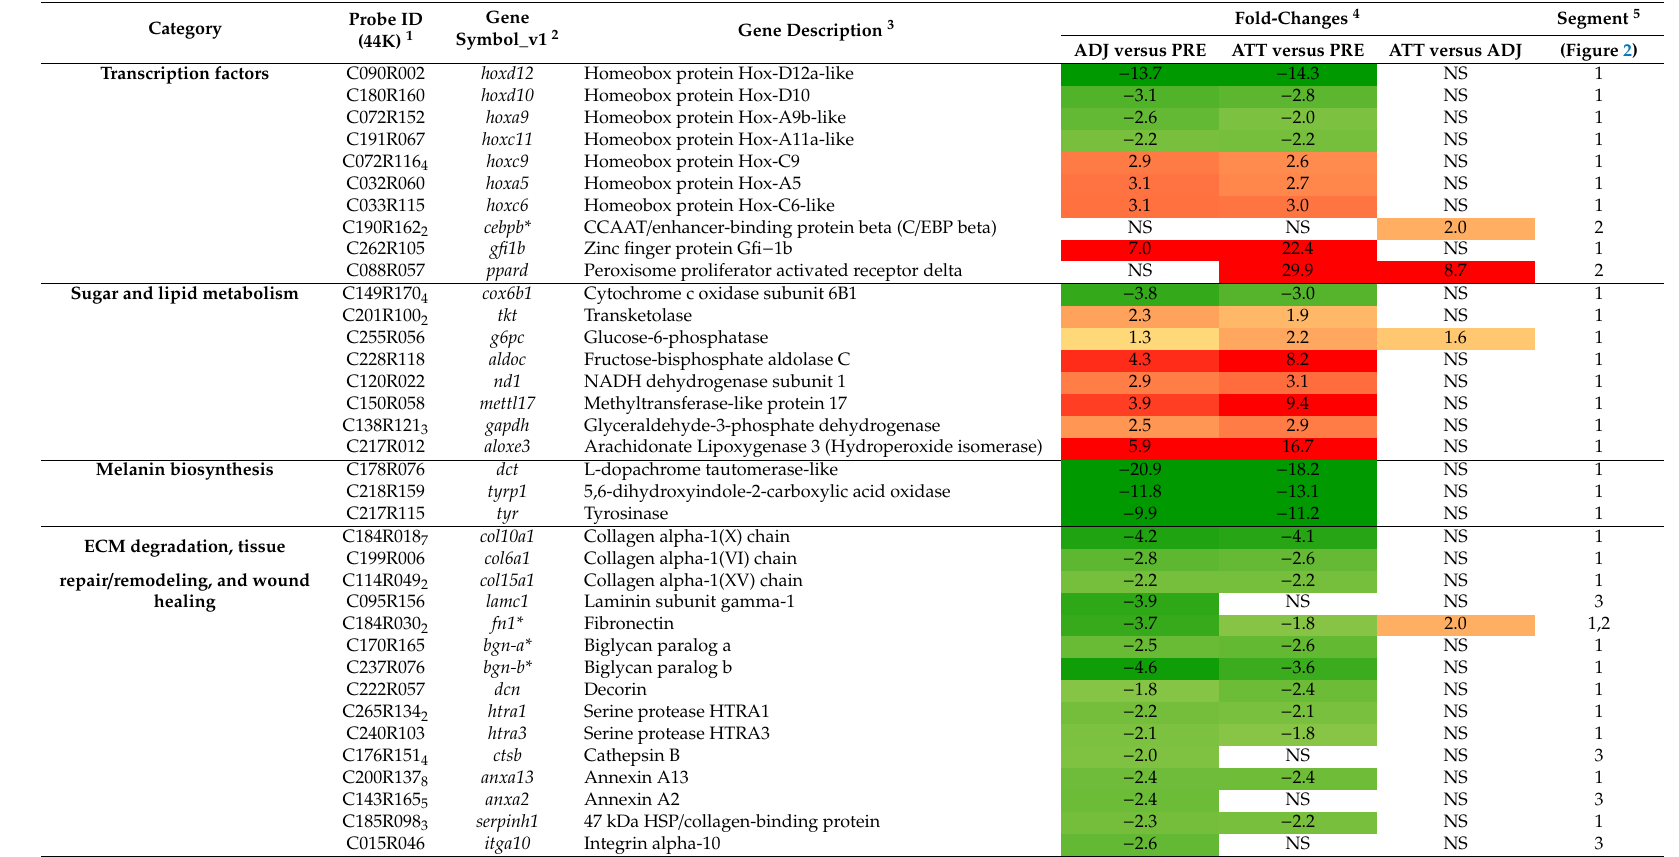
Table 1. Selected transcripts playing roles in di ff erent physiological processes (except those functioning primarily in immunity) and their fold-change values from SAM.